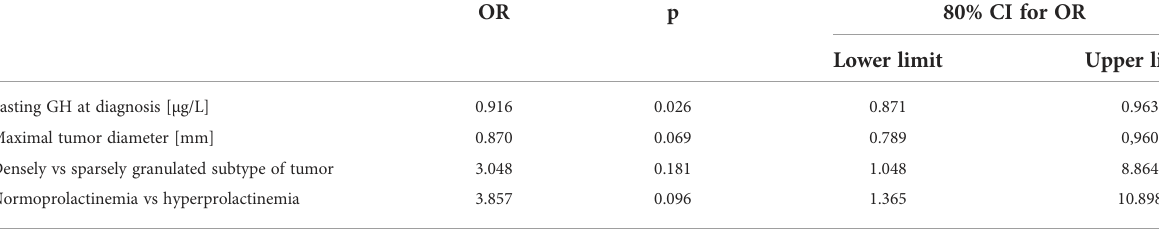
TABLE 4 Multivariate logistic regression for surgical remission, n=69.